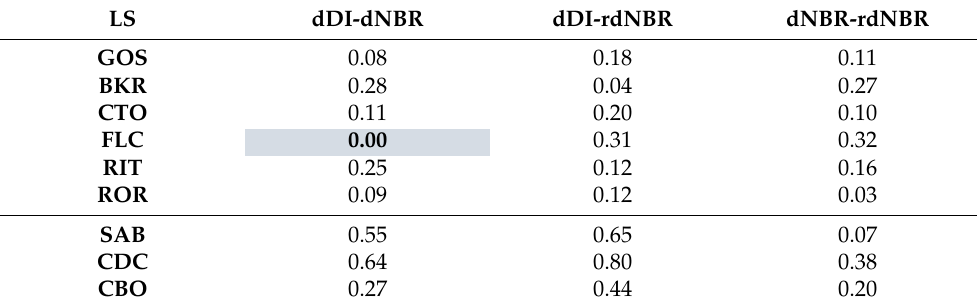
Table A2. Pearson’s R correlation coefficient as derived from the Welch’s t -test comparing Z scores for index values grouped by Landsystem (LS) Soil groups. Index values from the differenced Disturbance Index (dDI), differenced Normalised Burn Ratio (NBR) and the relativised differenced Normalised Burn Ratio (rdNBR) are compared in pairs to show significant differences in population means (all pairs assessed to be significant by p value 0.05 except highlighted and bold). Higher values indicate larger deviations from the compared means of individual